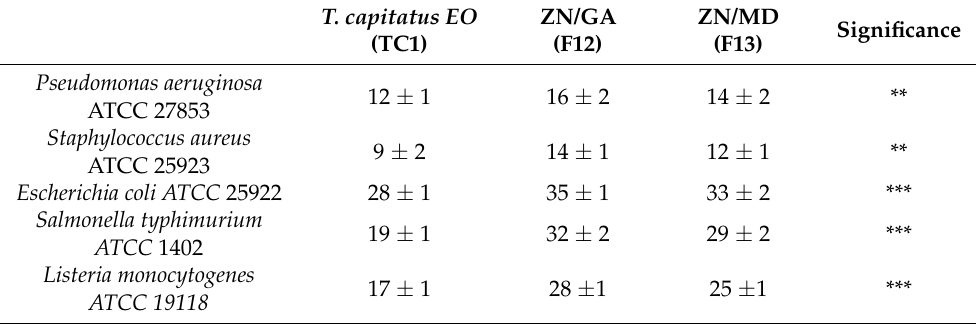
Table 6. Aromatograms for different bacteria exposed to the most promising T. capitatus (TC1) EO nanoparticles (F12 and F13) in comparison with pure EO. The diameters of the inhibition zones are given in